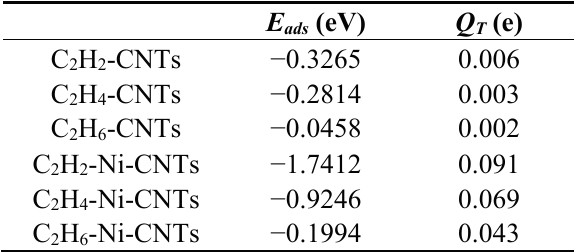
Table 1. Adsorption energy and charge